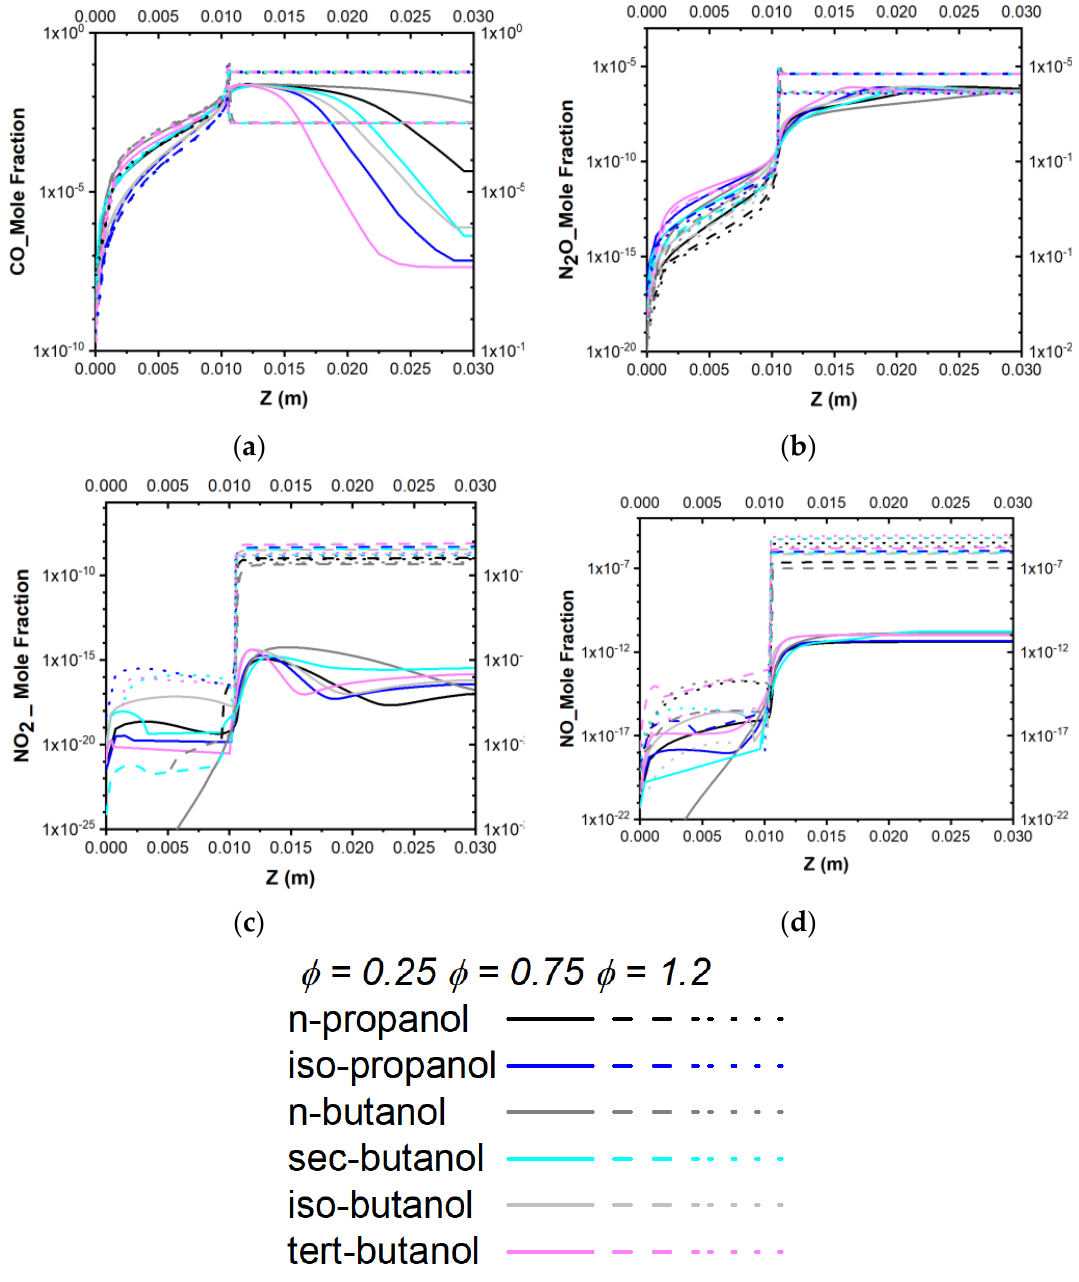
Figure 16. Model prediction for the mole fraction of ( a ) CO, ( b ) NO, ( c ) NO 2 , and ( d ) N 2 O emissions as a function of flame length in a free flame at 860 K and 36 atm for the unburned fuel/air-mixture. Due to the high excess air at φ = 0.25, the adiabatic flame temperature is below 1500 K, which leads to low a production of NO (mole fraction 4 × 10 − 12 to 1.7 × 10 − 11 ) and NO 2 (1 × 10 − 17 to 3.3 × 10 − 16 ) for all the C3 and C4 alcohols. The NO emissions are about